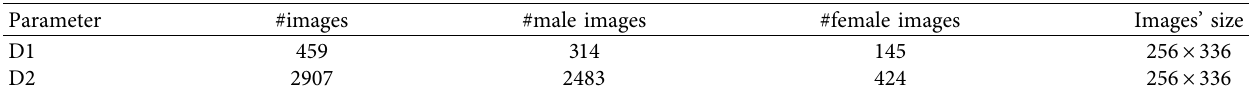
Table 1: Datasets